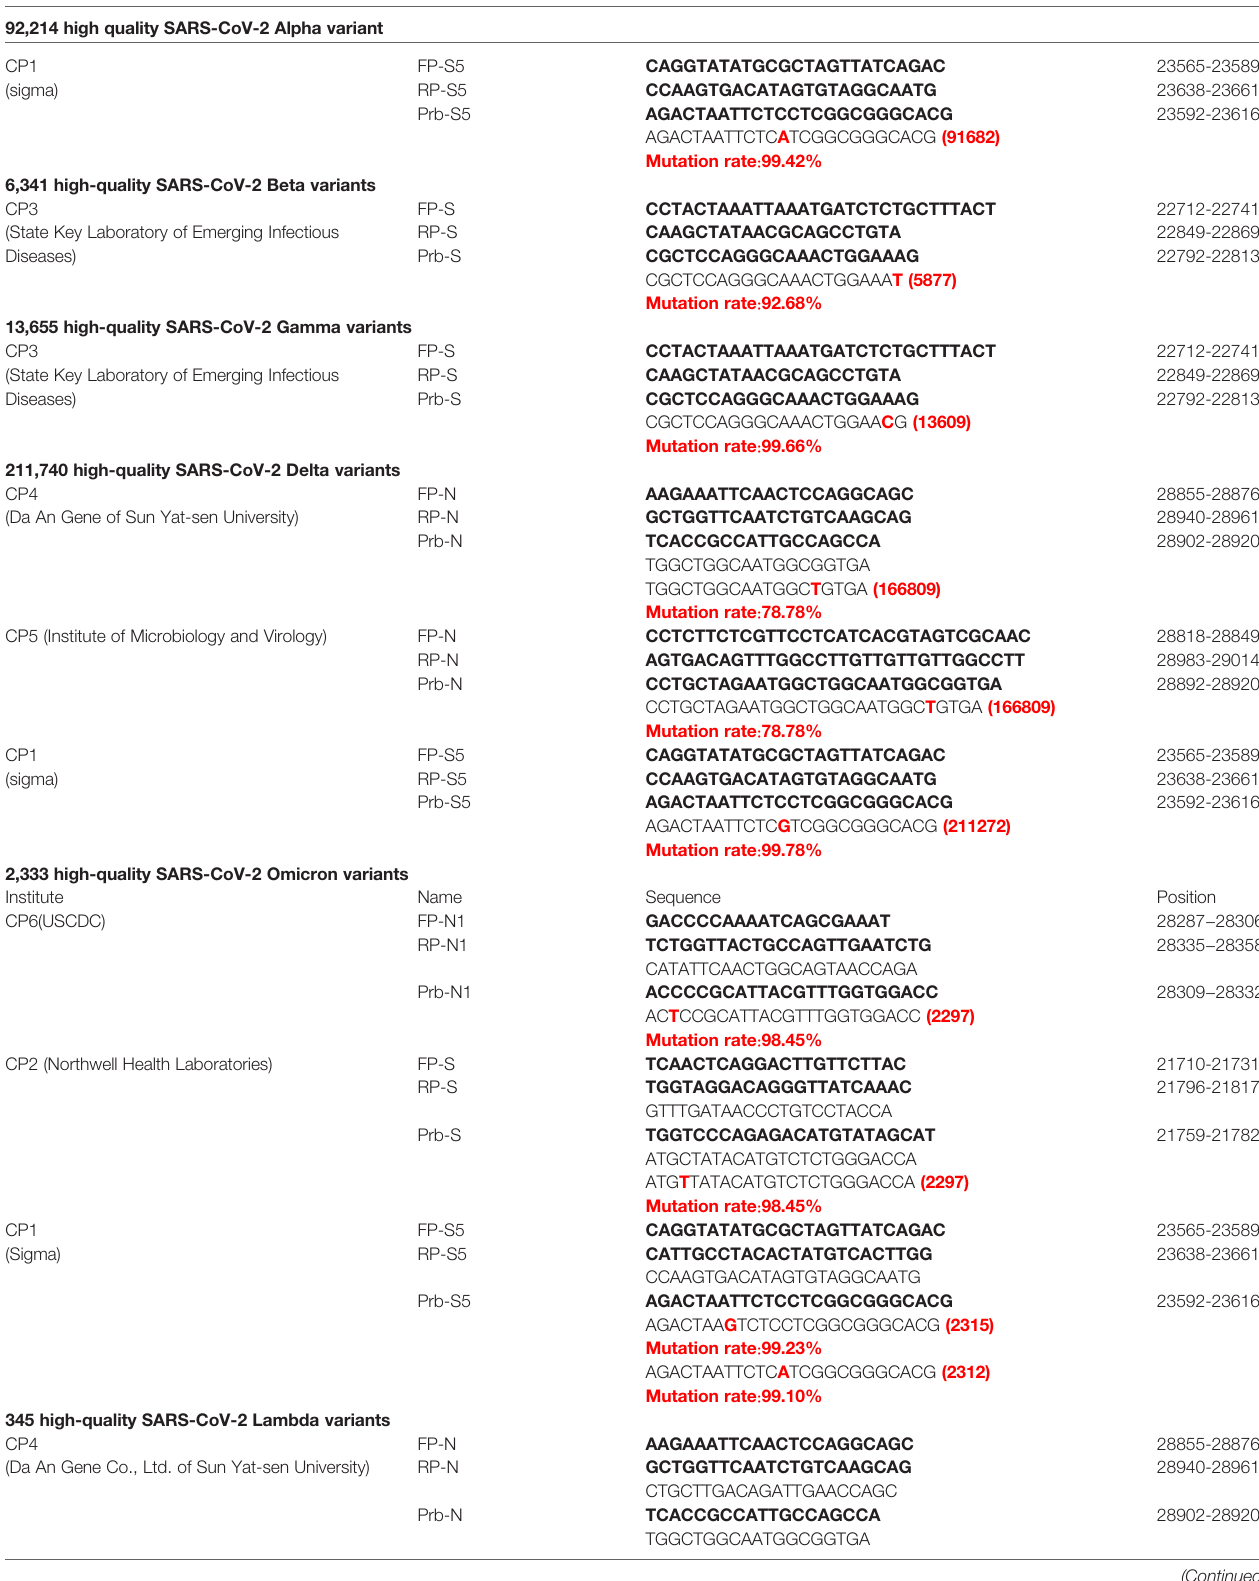
TABLE 1 | The point mutation of primer/probe sets in SARS-CoV-2 Variants. 92,214 high quality SARS-CoV-2 Alpha